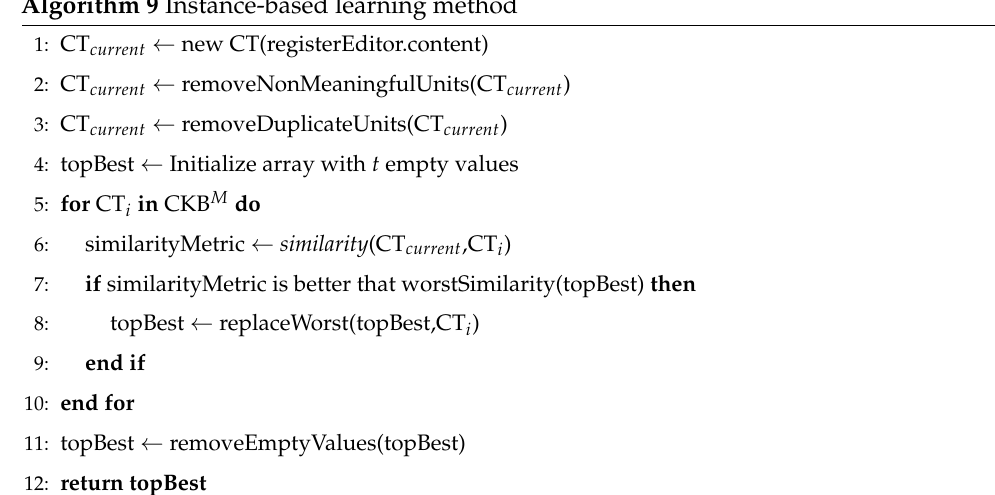
Algorithm 9 Instance-based learning